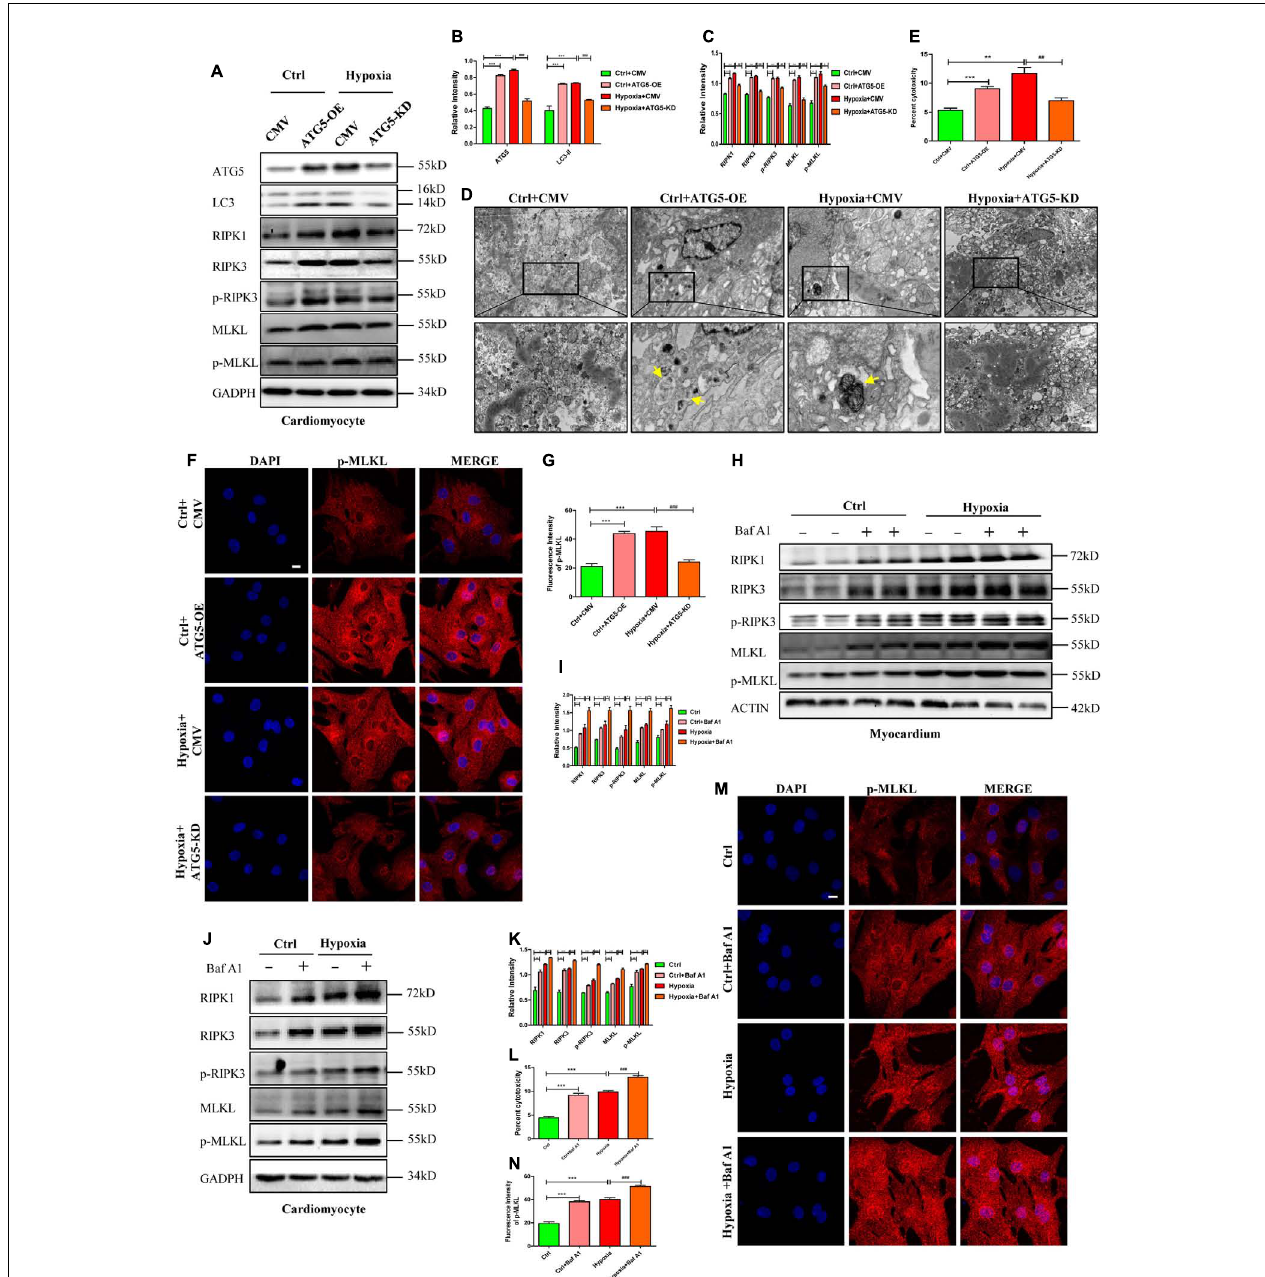
FIGURE 6 | RIPK1 and RIPK3 augmentation induced by autophagic flux impairment facilitates necroptosis under hypoxia. (A–C) ATG5 overexpression and ATG5 knockdown adenovirus were used to regulate autophagy under normoxia or hypoxia, respectively. After that, western blot and statistical analysis was performed to detect the levels of ATG5, LC3, RIPK1, RIPK3, p-RIPK3, MLKL, and p-MLKL. Mean ± SEM, n = 3. ** p < 0.01 and *** p < 0.001 versus the Ctrl+CMV group, # p < 0.05, ## p < 0.01 and ### p < 0.001 versus the Hypoxia+CMV group. (D) Representative images of autophagosome in corresponding groups in panel (A) . Yellow arrow indicates an autophagosome. Scale bar, 0.5 µ m, n = 3. (E) LDH leakage analysis was performed to determine cell death. Mean ± SEM, n = 5. ** p < 0.01 and *** p < 0.001 versus the Ctrl+CMV group, ## p < 0.01 versus the Hypoxia+CMV group. (F,G) . Representative confocal images and statistical analysis of p-MLKL in corresponding groups in panel (A) . Mean ± SEM. *** p < 0.001 versus the Ctrl+CMV group, ### p < 0.001 versus the Hypoxia+CMV group. Scale bar, 10 µ m, n = 3. (H–K) Bafilomycin A1 (Baf A1) was used to adjust autophagic flux under normoxia and hypoxia both in vitro and in vivo . Western blot and statistical analysis were then performed to determine the levels of RIPK1, RIPK3, p-RIPK3, MLKL, and p-MLKL in cardiomyocytes and myocardium, respectively. Mean ± SEM, n = 3. * p < 0.05, ** p < 0.01 and *** p < 0.001versus the control group, # p < 0.05, ## p < 0.01 and ### p < 0.001 versus the hypoxia group. (L) LDH leakage analysis was performed to determine cell death of corresponding groups in panel (E) . Mean ± SEM, n = 5. *** p < 0.001 versus the control group, ### p < 0.001 versus the hypoxia group. (M,N) Representative confocal images and statistical analysis of p-MLKL in corresponding groups in panel (G) . Mean ± SEM. *** p < 0.001 versus the Ctrl group, ### p < 0.001 versus the Hypoxia group. Scale bar, 10 µ m, n = 3.